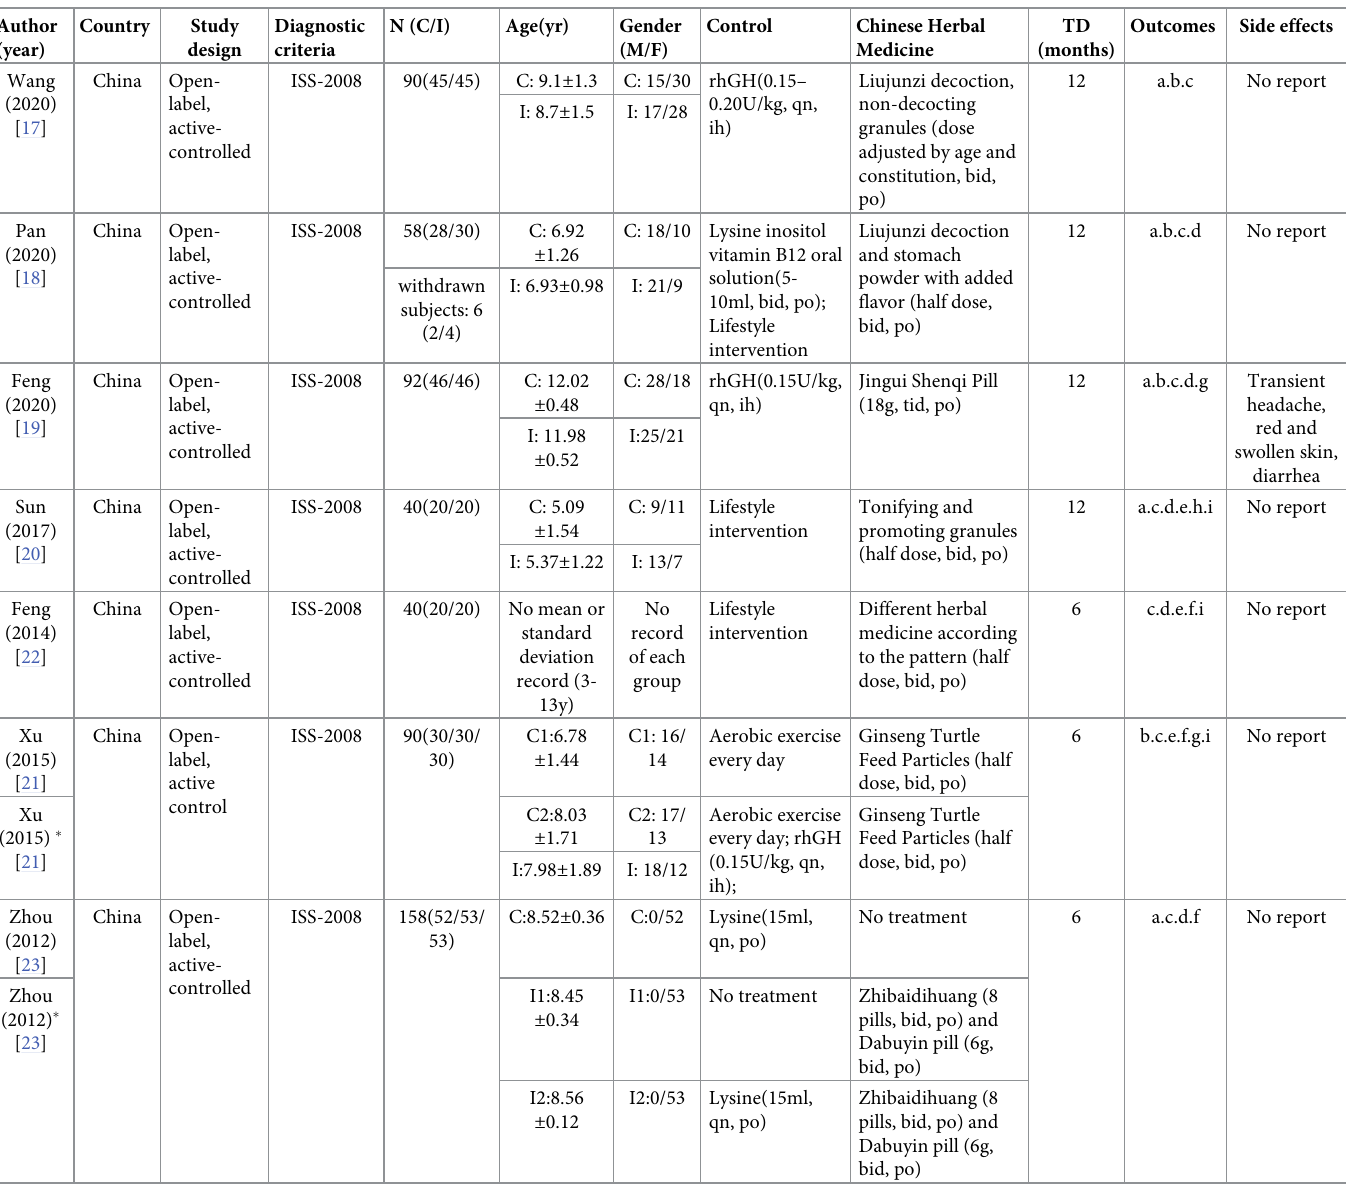
Table 1. Study characteristics in the systematic review and